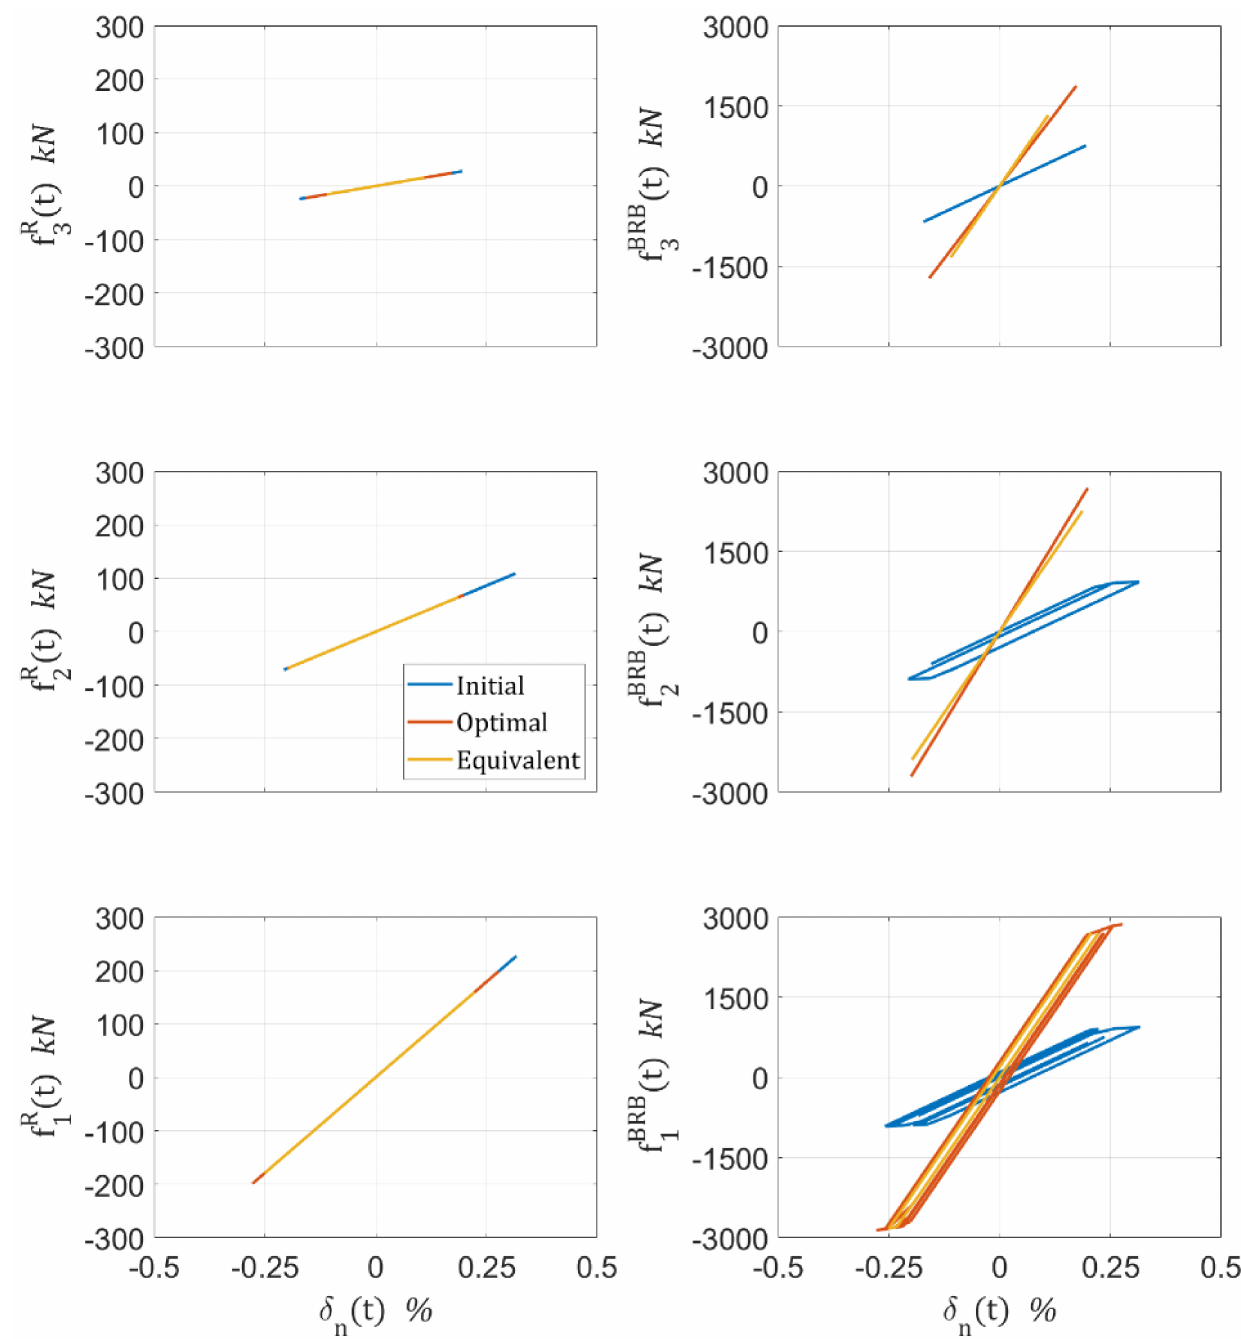
Figure 10. Hysteretic resisting forces of the three-story frame system under the Valparaiso 2017